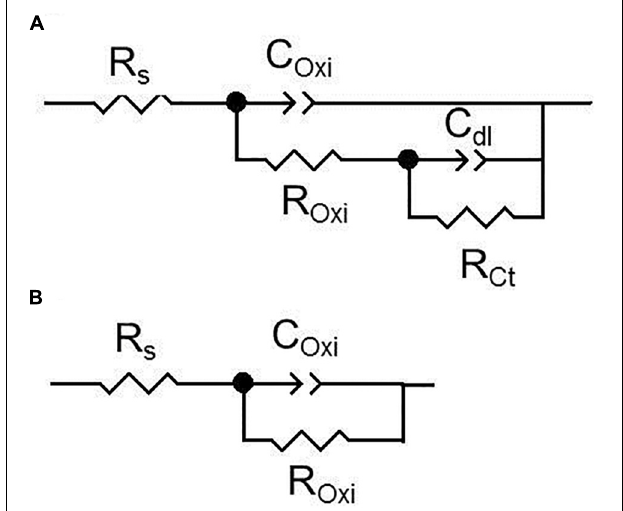
FIGURE 7 | (A,B) Equivalent electrical circuits used to simulate EIS spectra for as-cast, solution treated and heat treatments at 200 ◦ C, 300 ◦ C and 400 ◦ C conditions of Mg-10Gd alloy during different immersion time. Where, R s is the resistance of the solution, R Oxi and C Oxi are the resistance and capacitance of the oxide film, respectively. R Ct represents the charge transfer resistance and C dl is attributed to the double-layer capacitance (Silva Campos,